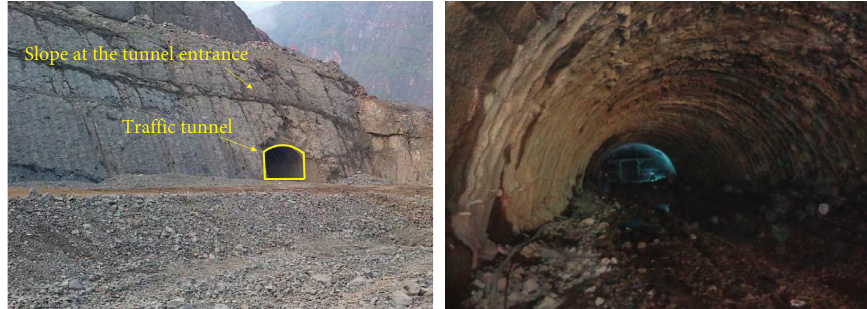
Figure 2: No. 2 traffic tunnel at the Baihetan hydropower station.